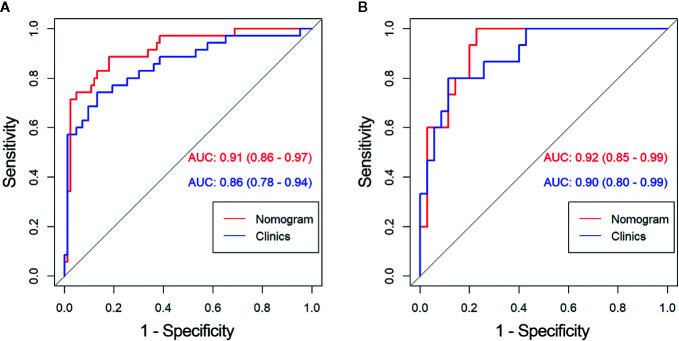
Comparison of receiver operating characteristic (ROC) curves between the radiomics nomogram and clinical model for the prediction of aggressive clear cell renal cell carcinoma (ccRCC) in the (A) training and (B) validation cohorts. AUC, area under the receiver operating characteristic curve.